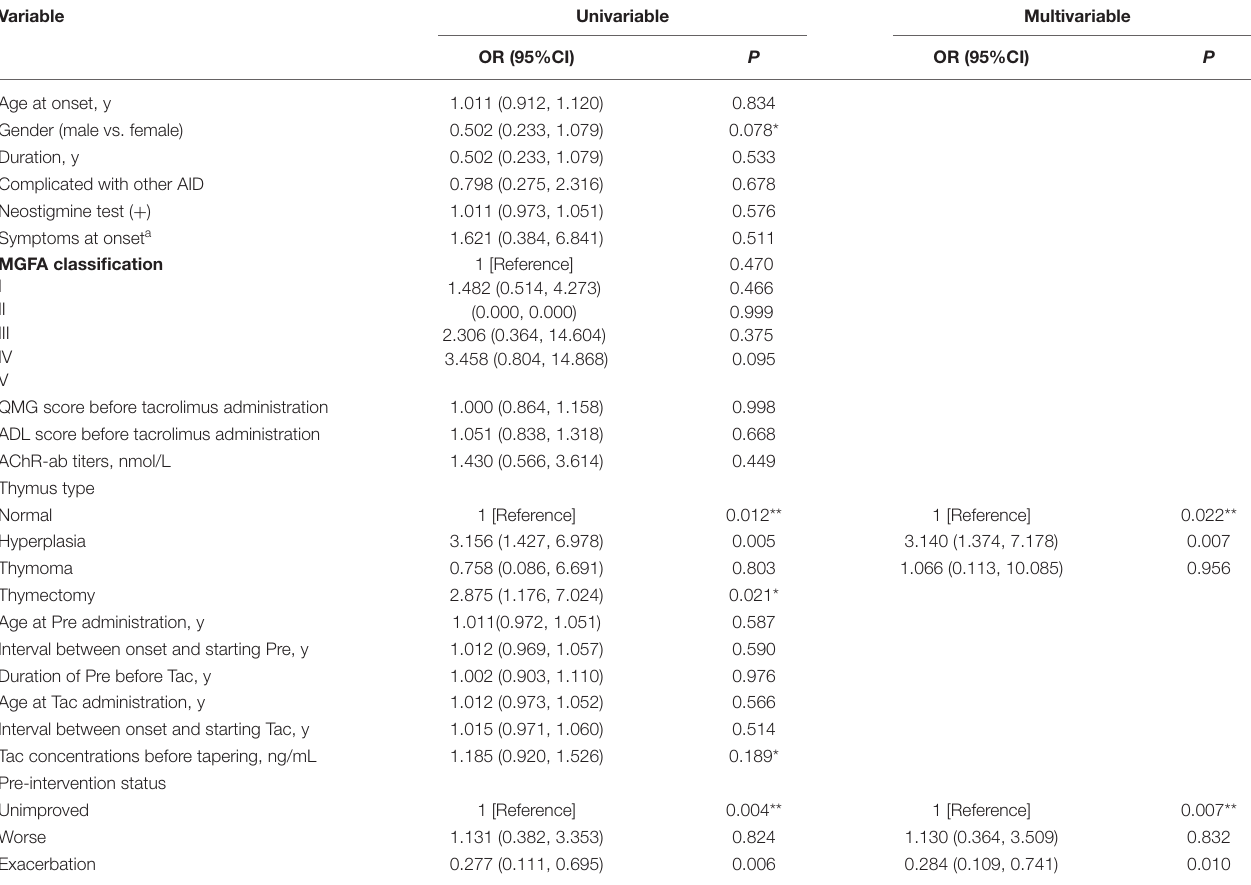
TABLE 2 | Univariate and multivariate analysis for the influencing factors of the tacrolimus efficacy.